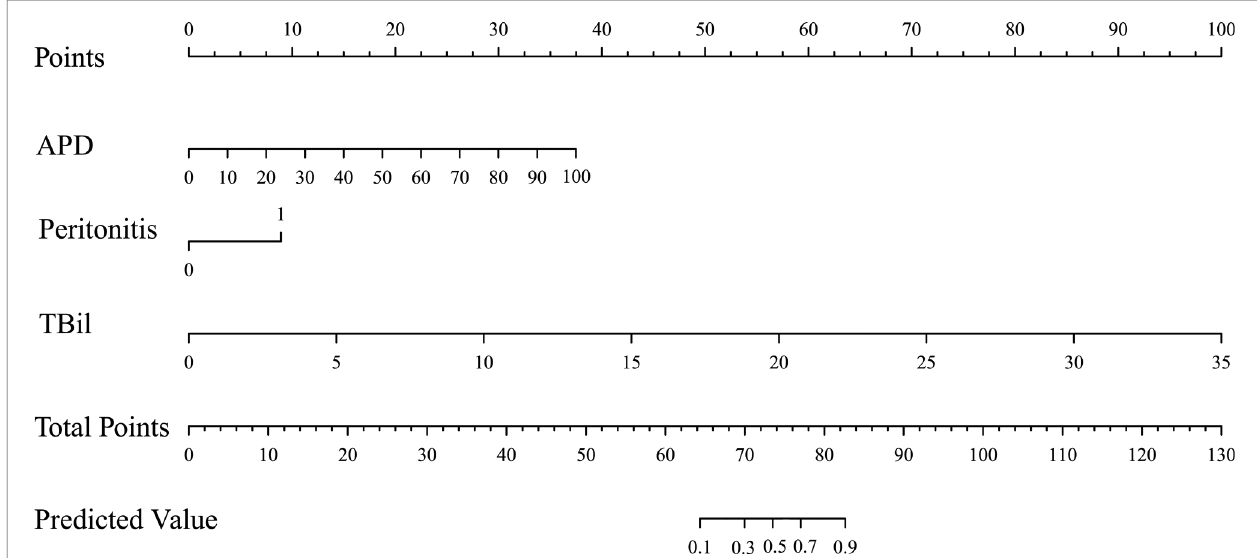
FIGURE 2 | Nomogram for predictive complicated appendicitis model in the elderly. APD, abdominal pain duration; TBil, total bilirubin.